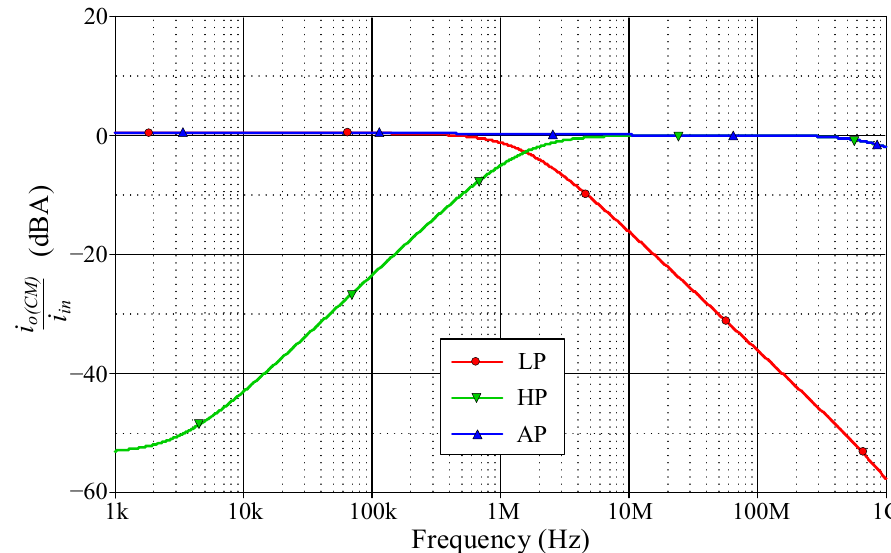
Figure 7. Simulated frequency responses of the proposed CM filter.